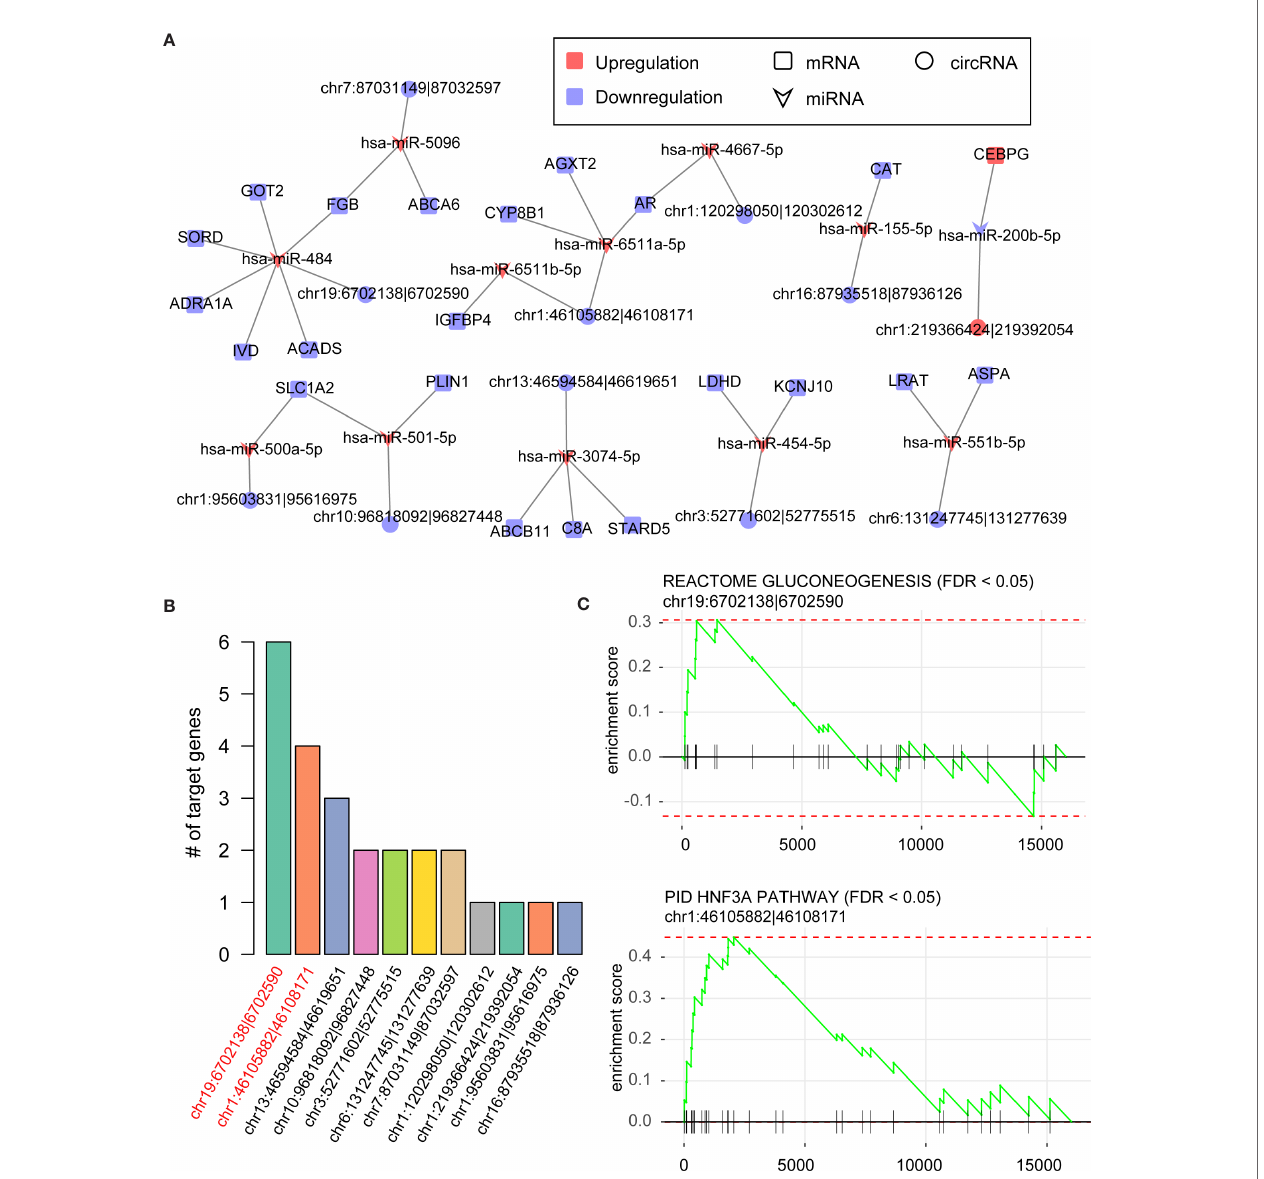
FIGURE 4 | The competing endogenous RNA (ceRNA) network and functional annotation of the key circRNAs. (A) The ceRNA network constructed by the miRNAs, differentially expressed genes and circRNAs. (B) The number of target genes of circRNAs in the ceRNA network. (C) The predicted pathways that the hsa_circ_0002130 and hsa_circ_0008774 may participate